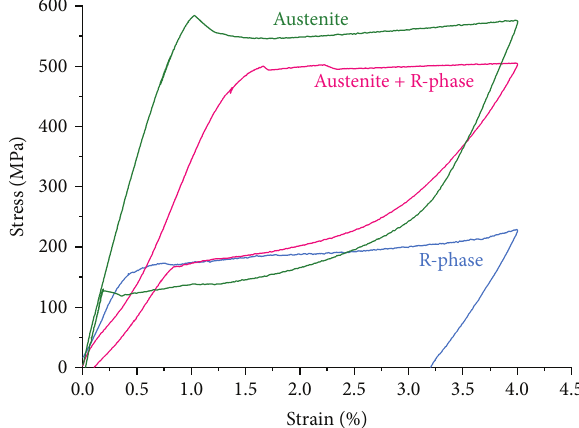
Figure 6: Load/unload behavior for three different NiTi wires used in this study.